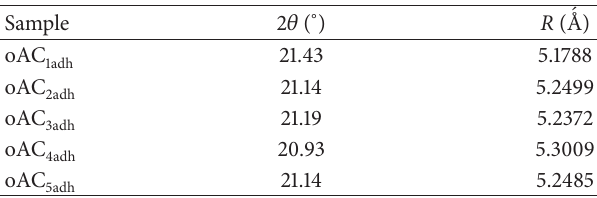
Table 2: The values of the mean distances between the closest neighbouring chains of the hydrogel films cross-linked with adipic –oAC dihidrazide (oAC 1adh 5adh